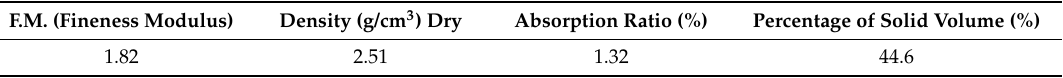
Table 5. Physical properties of fine